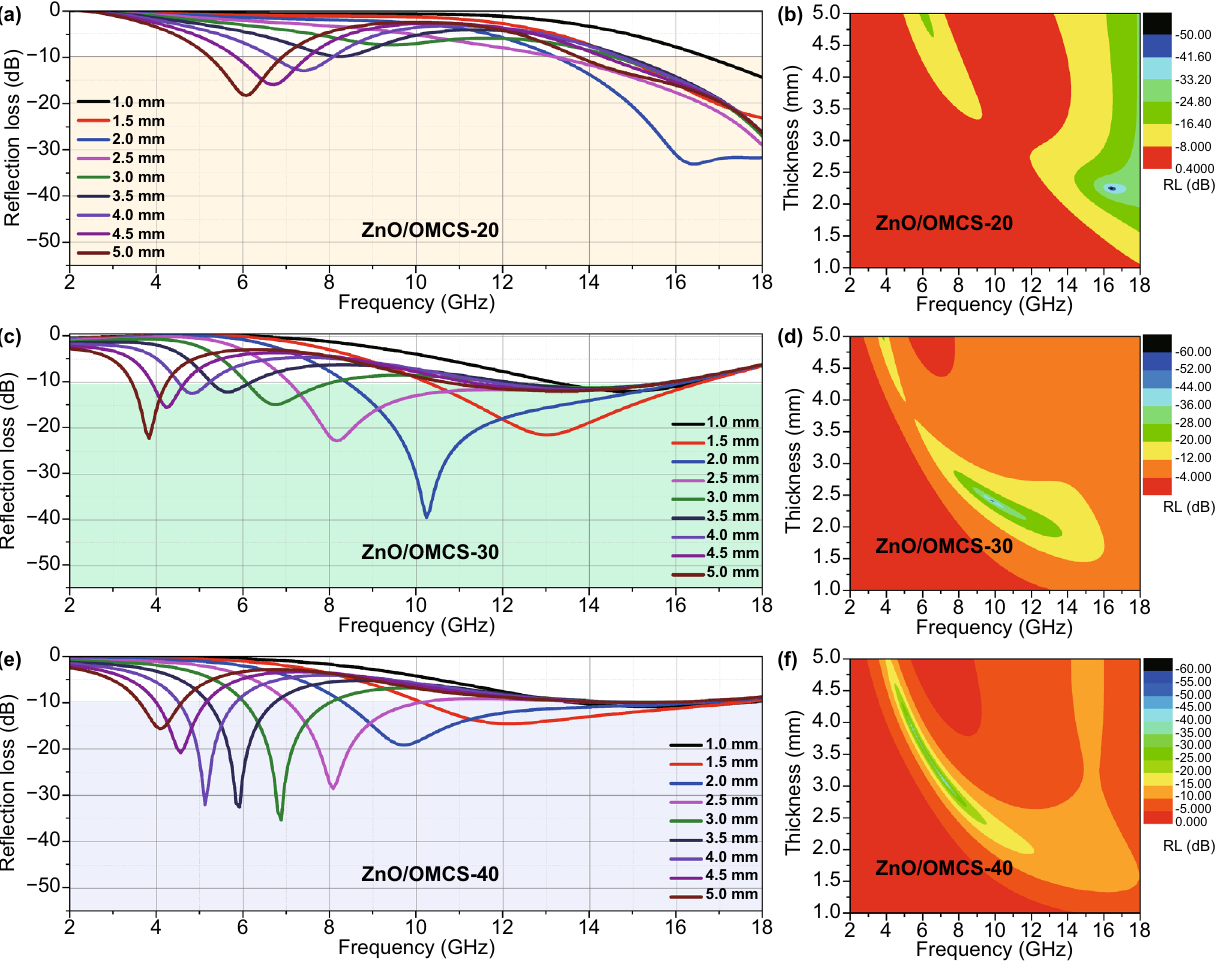
Fig. 8 Reflection loss and Delta value maps of ZnO/OMCS with different ZnO contents. a, b ZnO/OMCS-20; c, d ZnO/OMCS-30; e, f ZnO/